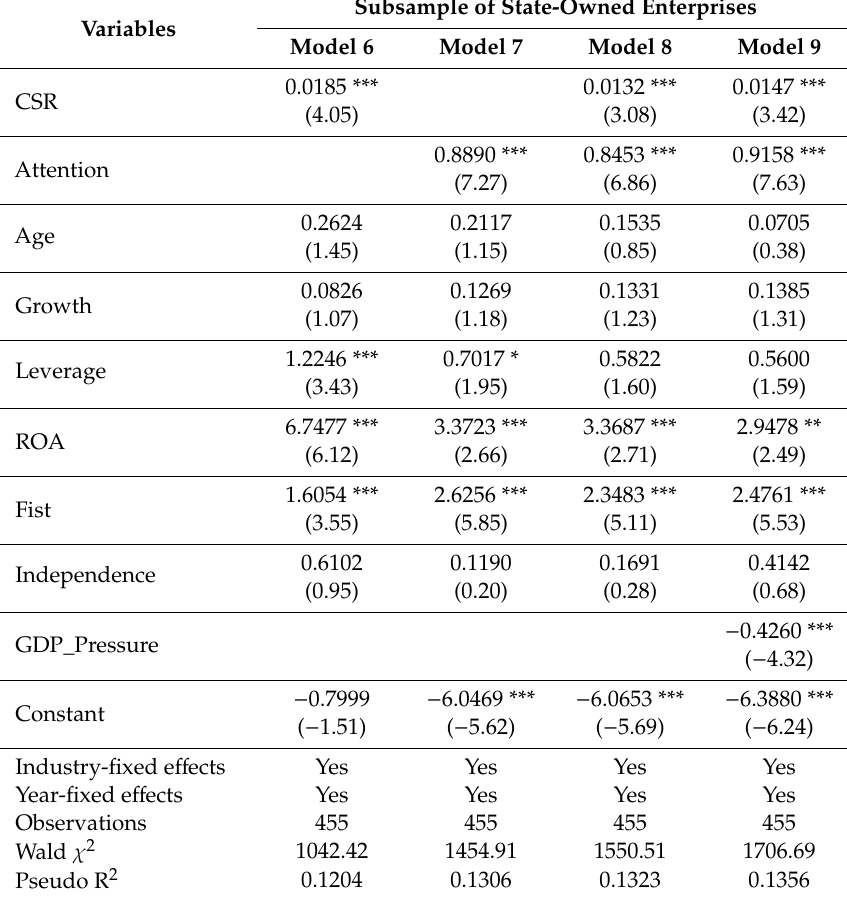
Table 5. The Regression Results of State-Owned